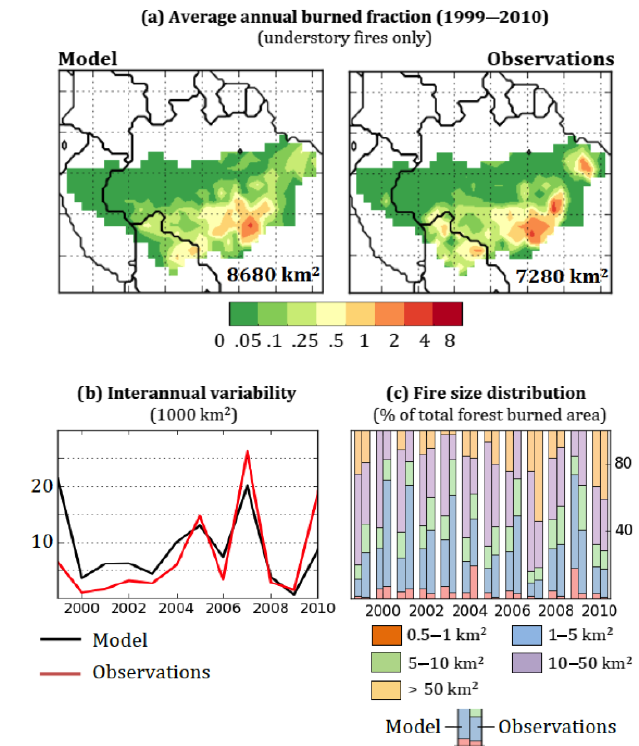
Figure 2. Spatial and temporal patterns of modeled and observed understory fires in the southern Amazon. Observation data are spe- cific to understory fires (Morton et al., 2011b); i.e., they do not in- clude deforestation or agricultural fires.